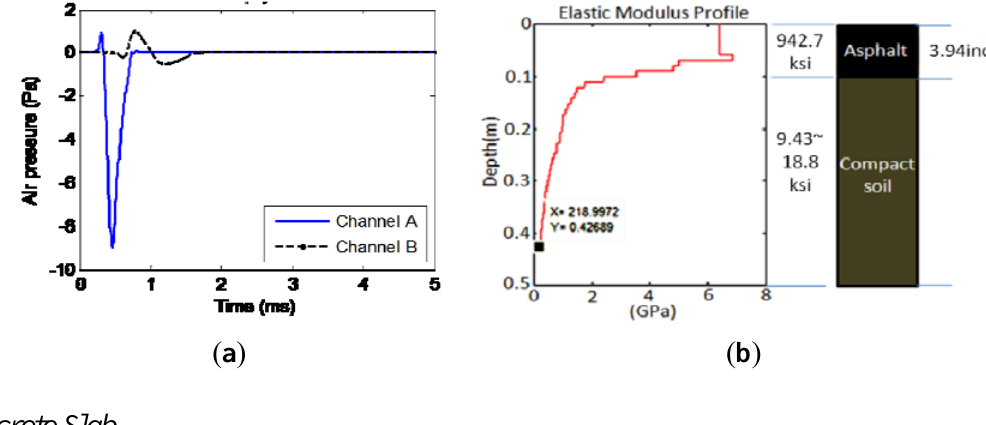
Figure 10. Testing on asphalt pavement. ( a ) Extracted radiating surface wave. ( b ) Estimated elastic modulus profile.